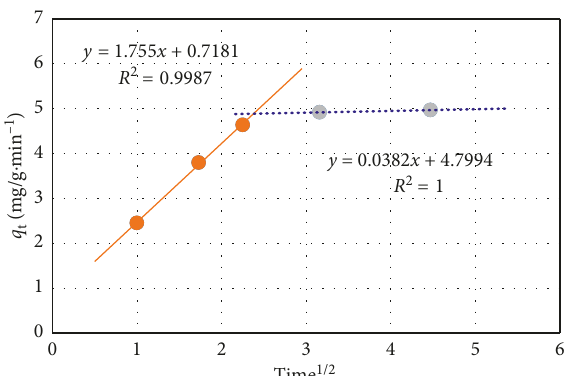
Figure 14: The Mories–Weber equation for the adsorption of 10mg · L − 1 EBT dye by 0.1 g/50mL NSG nanocomposite at a pH of 3.